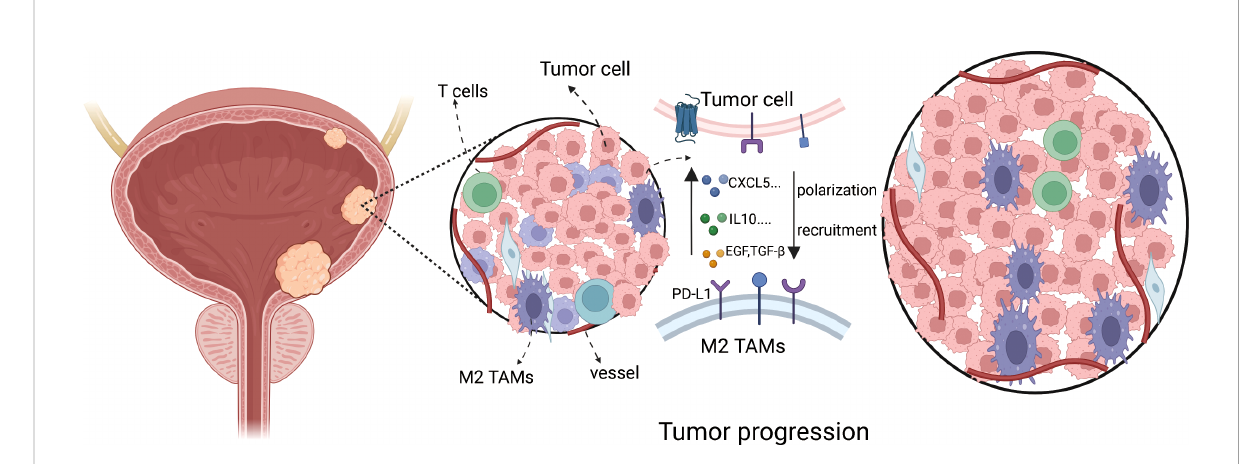
FIGURE 1 The schematic showing cross-talk between TAMs and bladder cancer cell